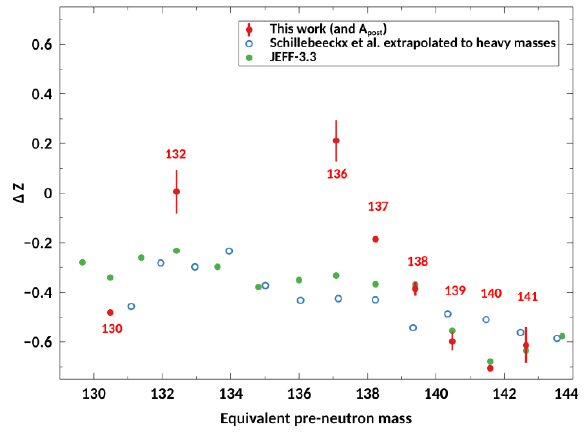
Fig. 3: Our measurements (red points labeled with the measured post-neutron emission mass A )) of the nuclear charge polarization as a function of the pre-neutron mass. post Results are compared to the Jeff libraries and the extrapolated points from light fragment measurement (P. Schillebeckx et al.